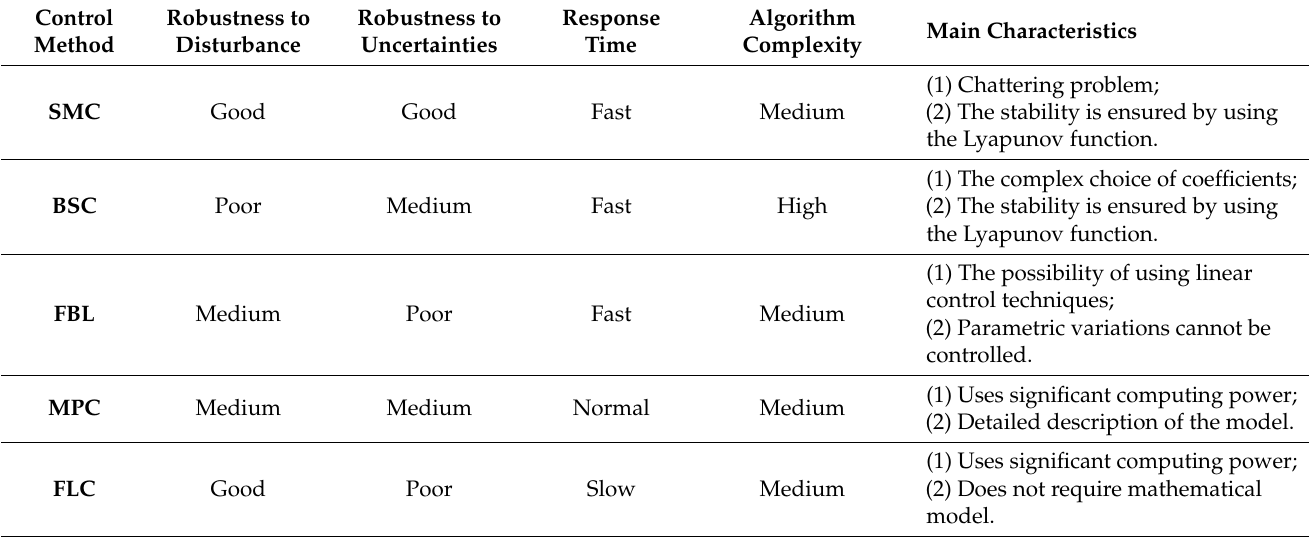
Table 7. Performance comparison of the nonlinear control strategies applied to the power